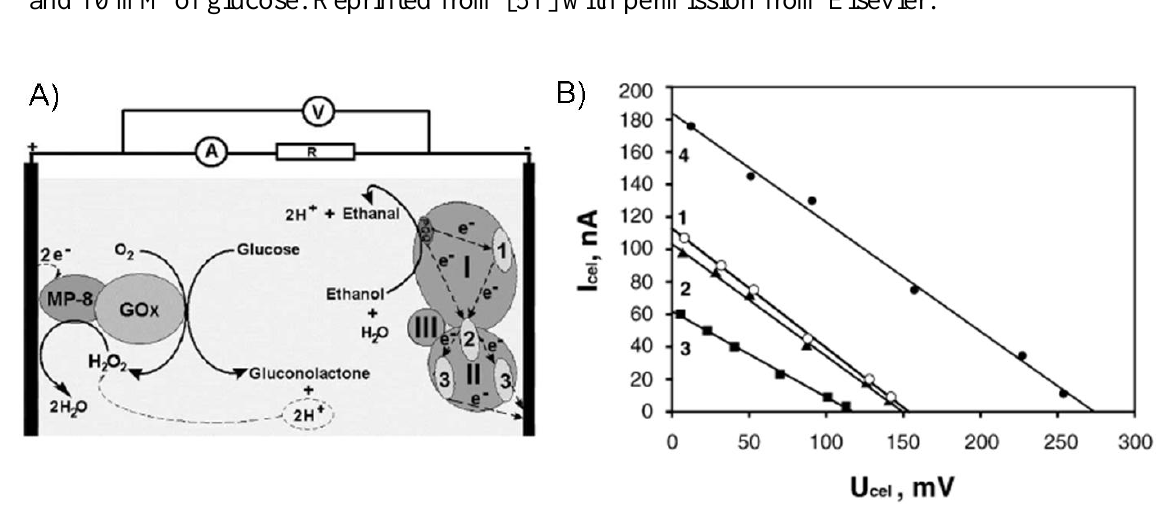
Figure 13. (A) Schematic configuration of a biofuel cell employing ethanol and glucose as fuels and QH-ADH and MP-8/GOx as catalytic anode and cathode, respectively. (B) Current-voltage behavior of the respective biofuel cell in presence of (1) 10 mM hydrogen peroxide, (2) 10 mM of glucose, (3) 10 mM of ethanol and (4) 10 mM of ethanol and 10 mM of glucose. Reprinted from [51] with permission from